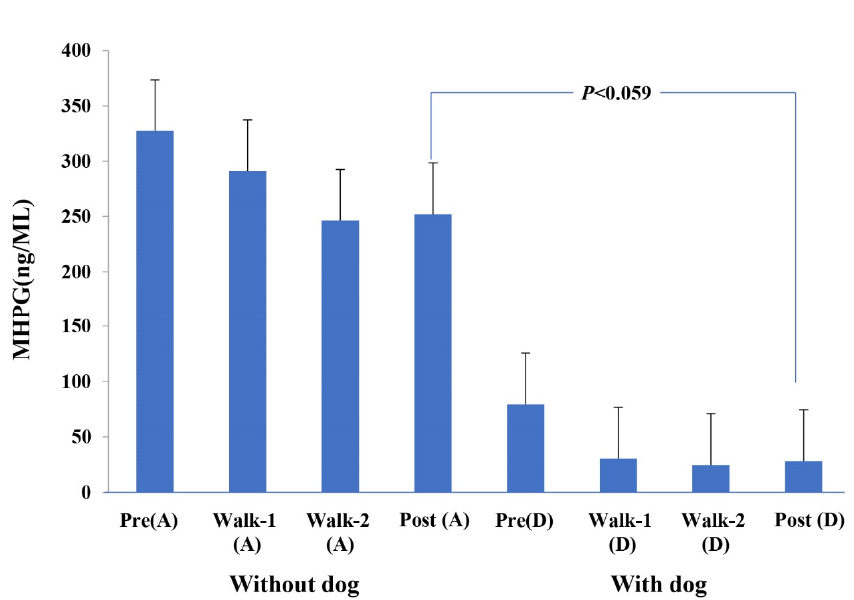
Figure 3. Scatter plot of salivary MHPG (horizontal axis) and GABA (vertical axis). Salivary concentrations of DOPAC ranged from 2.71 to 82.63 ng/mL (23.1 ± 3.1 ng/mL), with no apparent changes associated with walking.